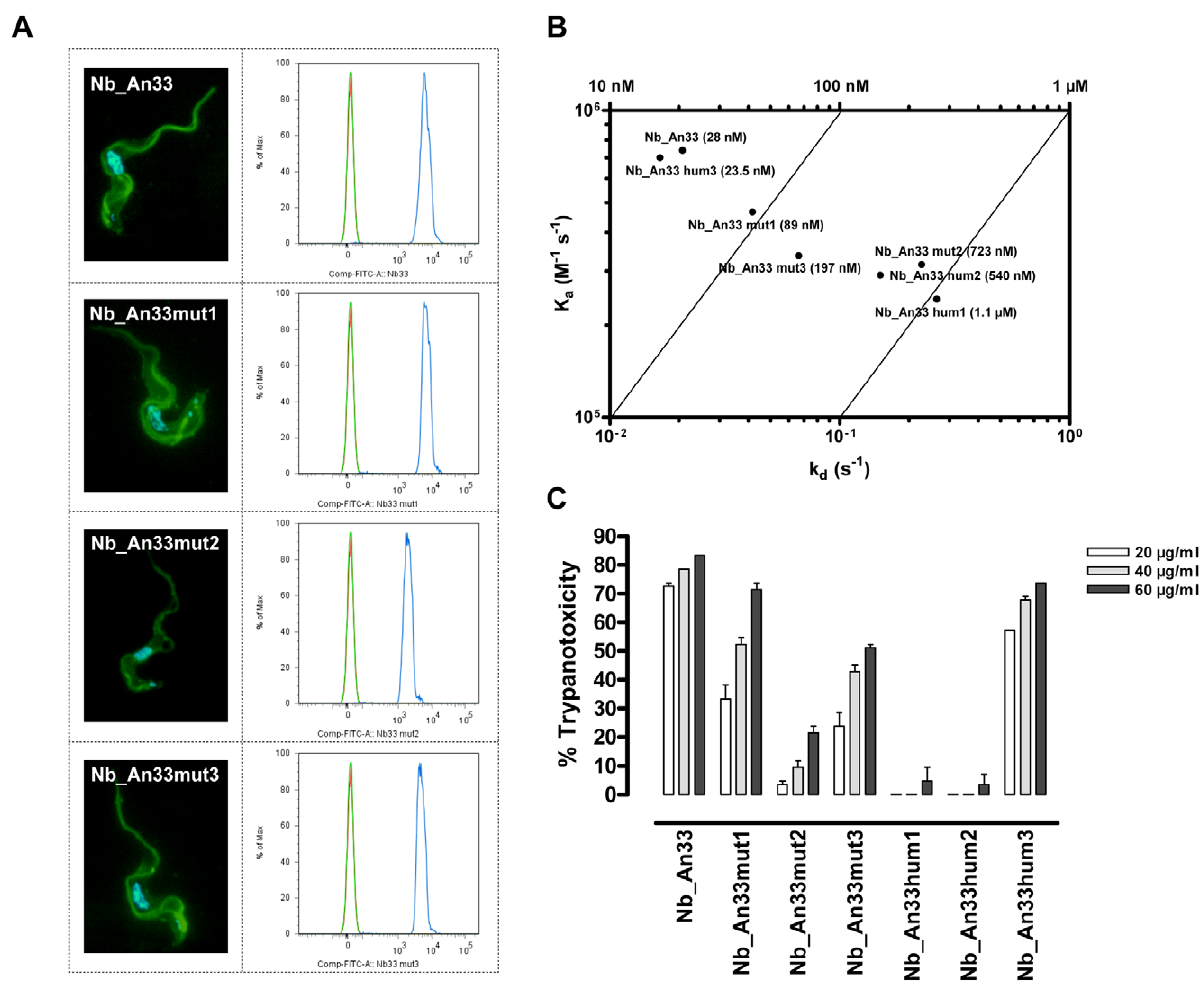
Figure 2. Functional characterization of the Nb_An33 variants. ( A ) Binding studies with ALEXA 488-labeled Nb_An33 and Nb_An33mut1-3 variants onto purified bloodstream form T. brucei : fluorescence microscopic images of trypanosomes stained with DAPI and the respective Nanobodies and flow cytometric analysis of trypanosomes incubated without Nanobody (green line), with the different Nb_An33 variants (blue line) or with an ALEXA 488-labeled control Nanobody (red line). ( B ) Dot plot representation with isoaffinity lines of the individual k a , k d and K D affinity constants of Nb_An33, the paratope variants (Nb_An33mut1-3) and humanized framework variants (Nb_An33hum1-3). ( C ) Trypanotoxic activity at 37 u C measured after 18 hours with 20, 40 and 60 m g/ml of the different Nb_An33 variants in HMI-9/10%FCS medium.